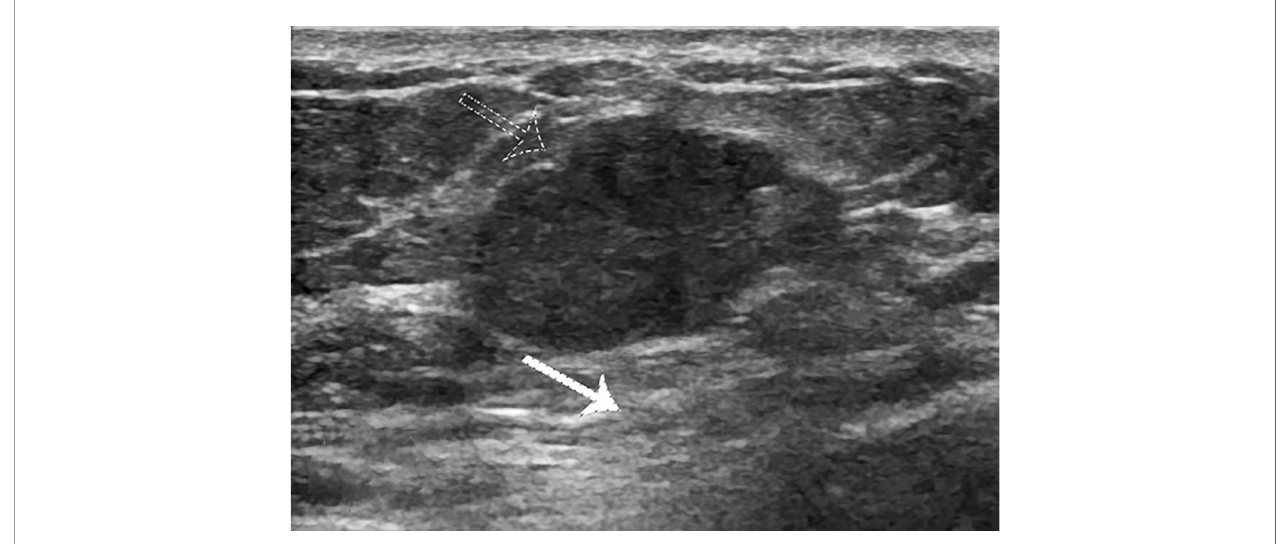
FIGURE 5 | Case 3: A 49-year-old woman with conventional pure mucinous breast carcinoma (cPMBC) presented with a hypoechoic mass (1.7 × 1.4 × 1.3 cm) in the right breast. The lesion presented with a circumscribed margin (dotted arrow), irregular shape, and enhanced posterior echo (white